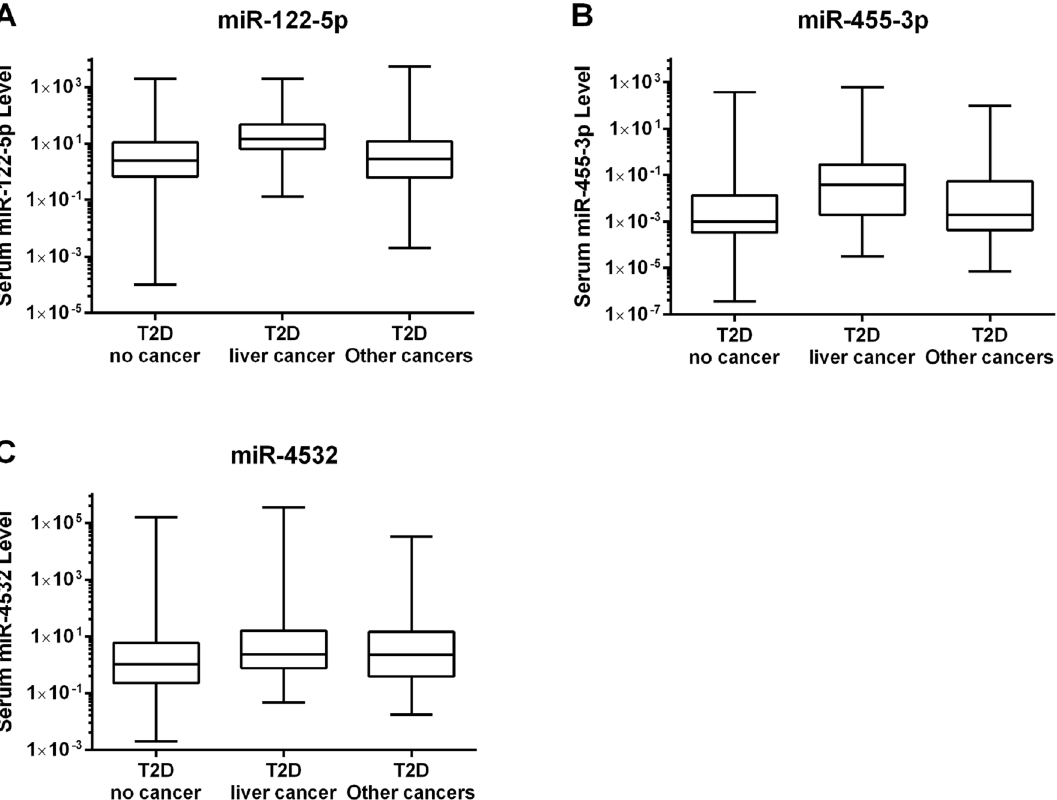
Figure 3. Expression of serum miRNA levels in T2D patients. Serum levels of ( A ) miR-122-5p, ( B ) miR-455-3p and ( C ) miR-4532 are shown in box and whiskers in T2D no cancer (T2D-CF), T2D liver cancer (T2D-LC) and T2D other cancer patients (T2D-NLC). The box represents the 25th to 75th percentile range and the whiskers represent the minimum to maximum. The horizontal line in the box represents the